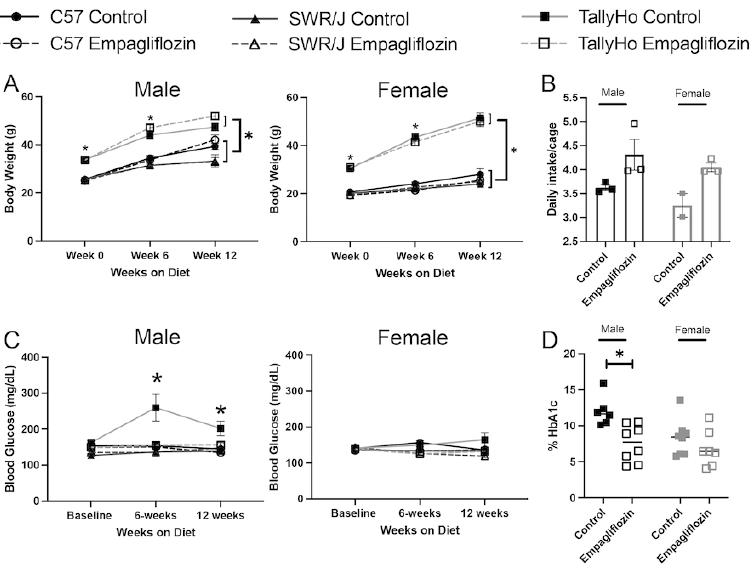
Figure 1. Empagliflozin attenuates blood glucose in male TallyHo mice independent of changes in body weight. Male and female TallyHo (squares), SWR/J (triangles), and C57BL6J (C57; circles) were fed a high milk-fat diet in the absence (filled symbols) or presence (open symbols) of 10 mg/kg BW Empagliflozin. ( A ) Body weight was tracked weekly and plotted at weeks 0, 6, and 12. * indicates p < 0.05 for TallyHo vs. C57BL6J and SWR/J mice. No statistical differences were detected between control and Empagliflozin-treated mice. ( B ) Daily food intake (averaged/cage) was measured for control and Empagliflozin-treated TallyHo male and female mice. ( C ) To track blood glucose values, mice were fasted overnight before being refed for 2 h. Following the refeeding, blood glucose values were measured using a glucometer. * indicates p < 0.05 for TallyHo controls vs. all other groups. ( D ) Glycated hemoglobin was measured for control and Empagliflozin-treated TallyHo male and female mice. * p < 0.05 TallyHo control vs.